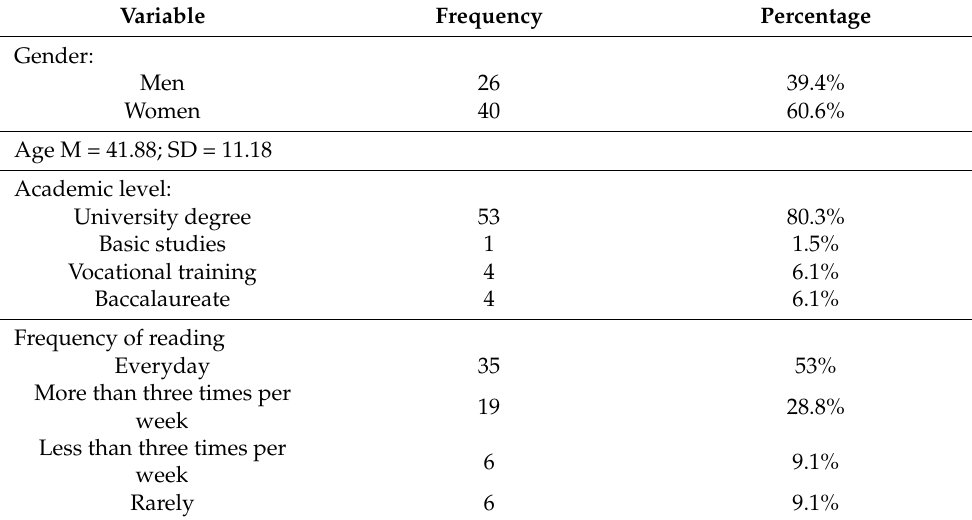
Table 1. Sociodemographic data and percentages from our